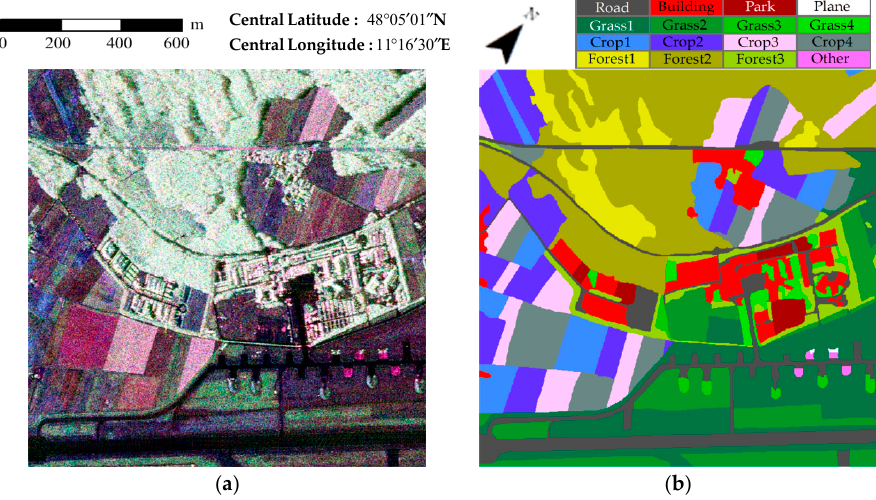
Figure 4. L-band, two-look ESAR PolSAR image in Oberpfaffenhofen as the third data set: ( a ) Pauli RGB image and ( b ) the ground truth map of ( a ).